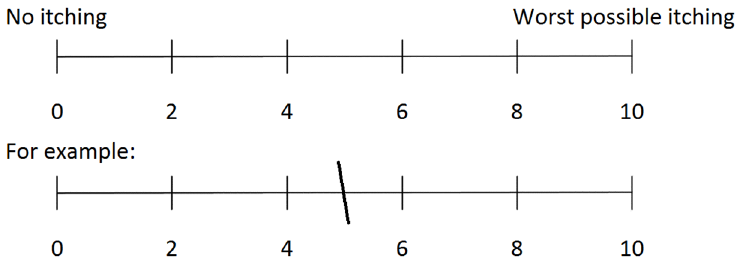
Figure 1. Visual Analogue Scale for the assessment of pruritus. The subjects should draw a line anywhere on the given scale that best represents the severity of their itching. Table 1. Components of the 5-D itch scale. All of these components are to be rated separately during the timespan of the past two weeks. The scores for each component are summed to an overall score ranging from a minimum of 5 to a maximum of 25 points [14].